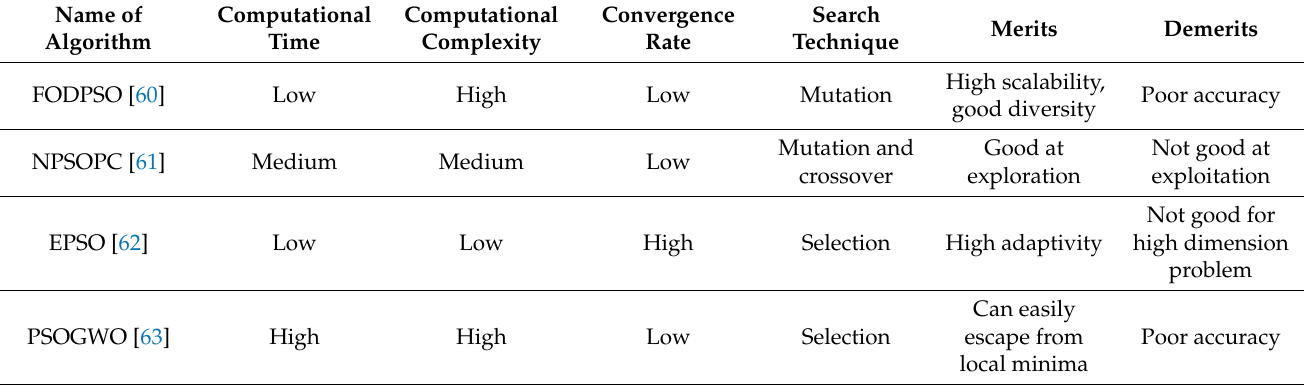
Table 3. Qualitative comparison of hybrid PSO for parameter estimation of PV cells or